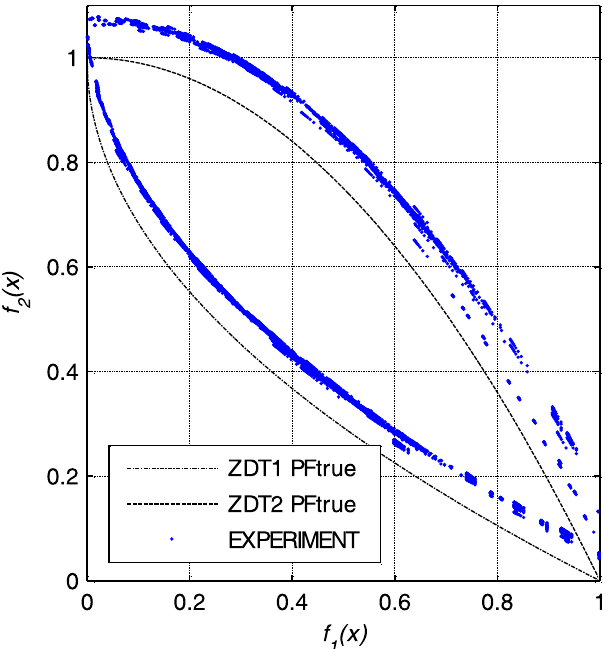
Fig. A.1. Ideal Pareto front (PFtrue) and test solution set